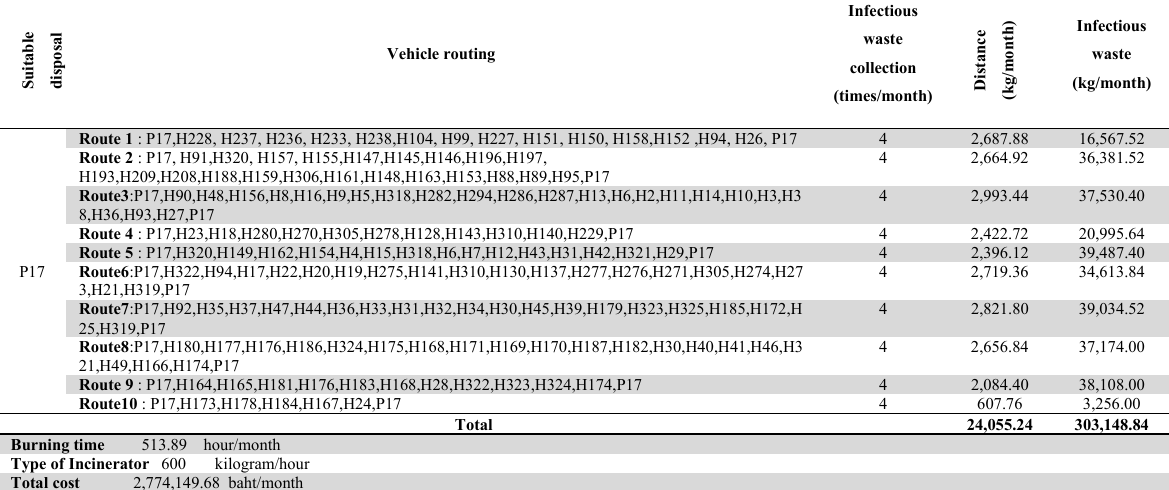
collection routes are represented by black lines. The orange circular point is the P20 location for establishing the incinerator site. The infectious waste collection routes are represented by orange lines. The green point represents the hospital with a frequency of infectious waste collection of eight times per month, which represents two infectious waste collection routes. The result of case study with the GRALNSP